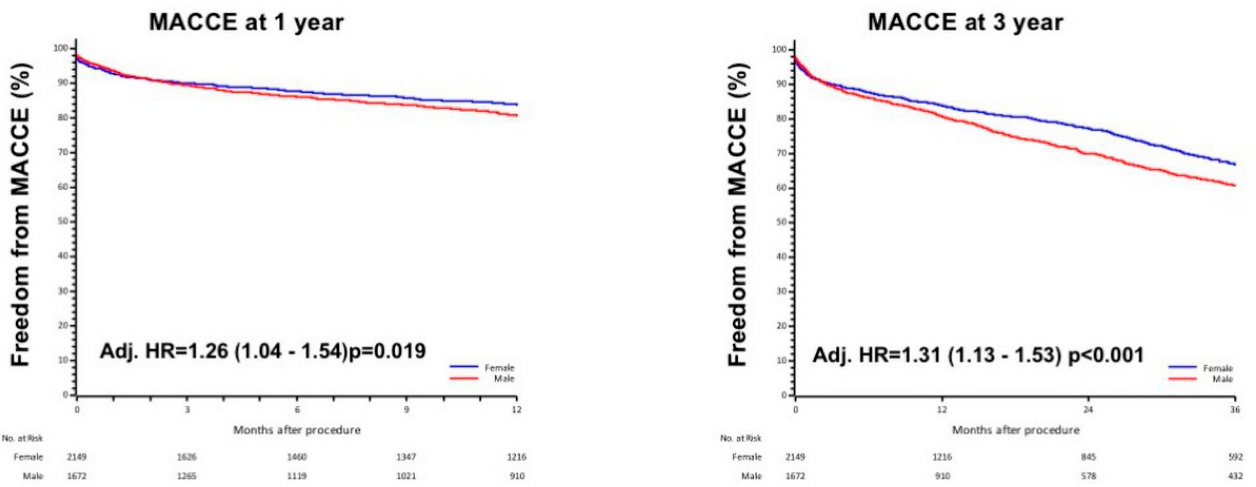
Figure 4. Composite endpoint (MACCE) at 1- and 3-year in male and female, adjusted respectively for age, STS score, eGFR, diabetes and for age, STS score, eGFR, diabetes and severe COPD.